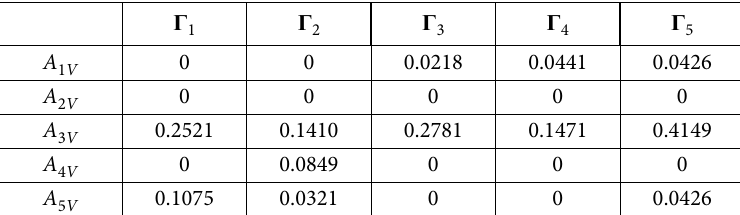
Table 4. The PDA of classical EDAS method